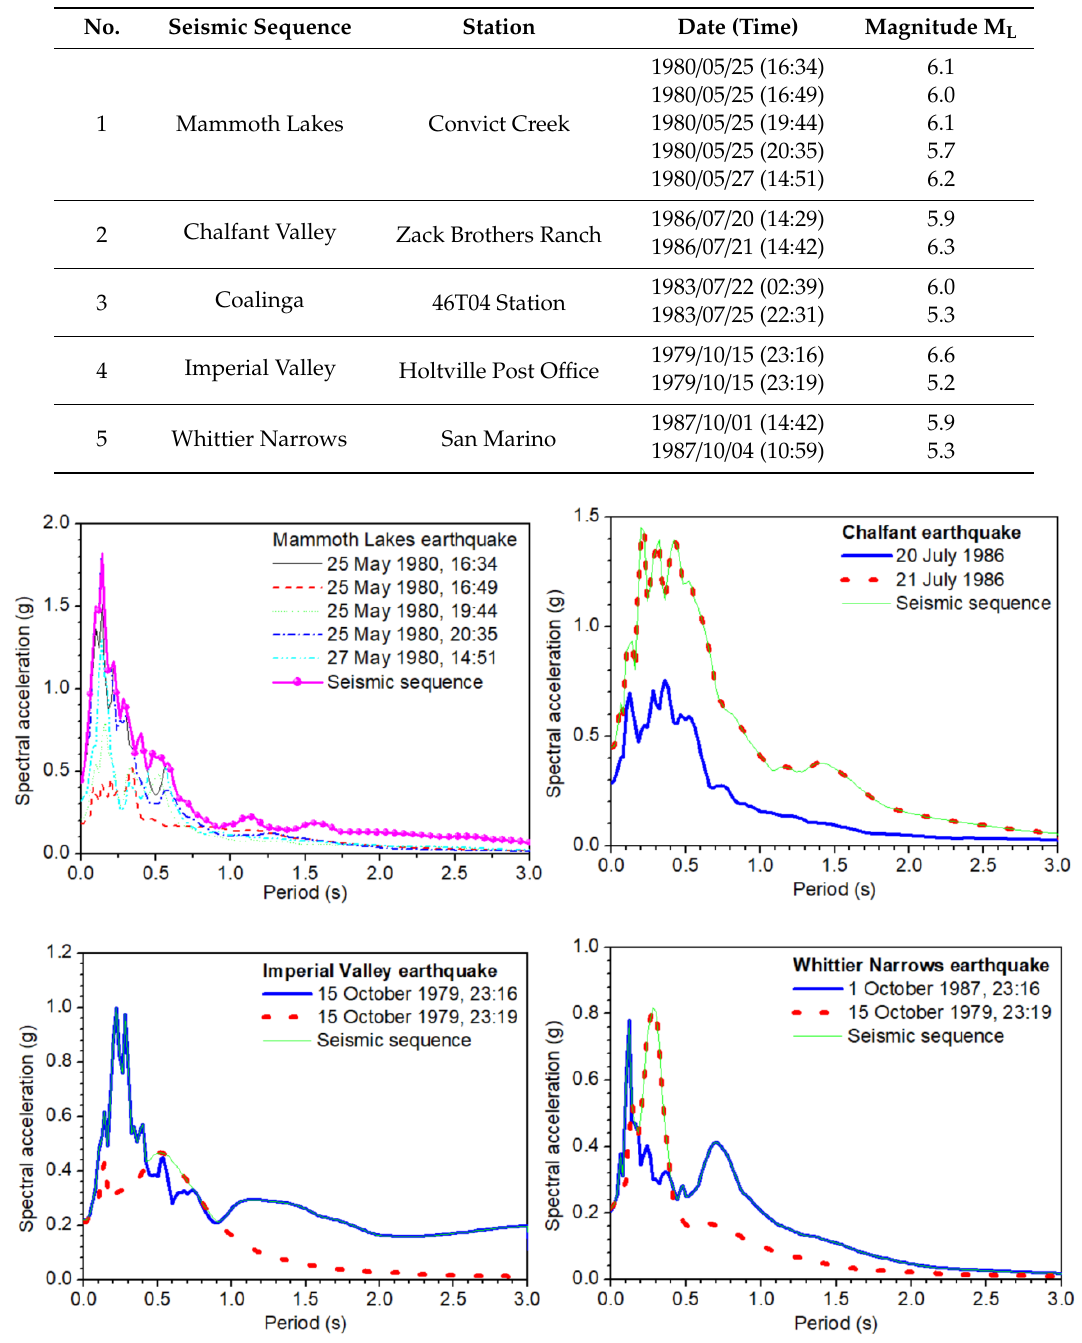
Table 2. Multiple earthquakes under consideration.